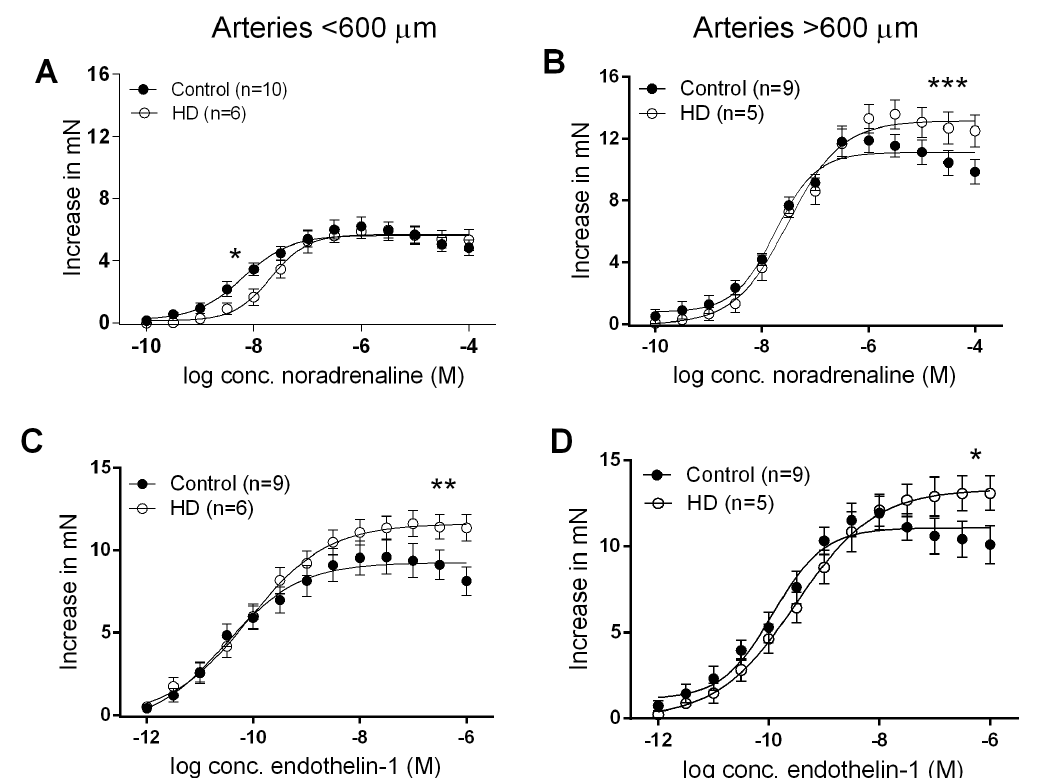
Fig. 1. Concentration-response curves to NA (A,B) and ET-1 (C,D) in isolated subcutaneous arteries obtained from HD patients and controls. Data are expressed as mean ¡ SEM and the comparison is by students t-test; * P , 0.05, ** P , 0.01, *** P , 0.001. HD, haemodialysis; n, number of arteries; M, molar; mN,